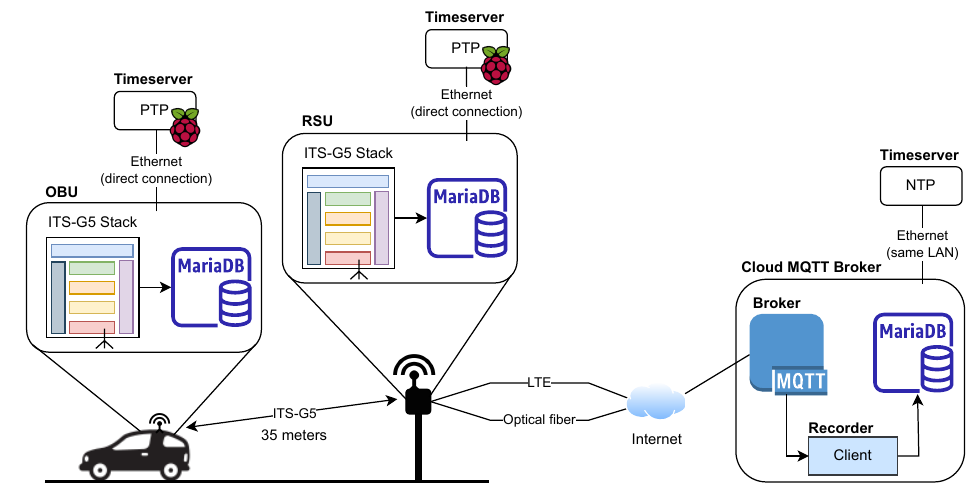
Figure 9. Setup used for performance measurements. A stationed vehicle continuously broadcasts CAMs through ITS-G5 which are then forwarded by an RSU to the cloud MQTT broker. A lightweight client in the broker server records the received messages.